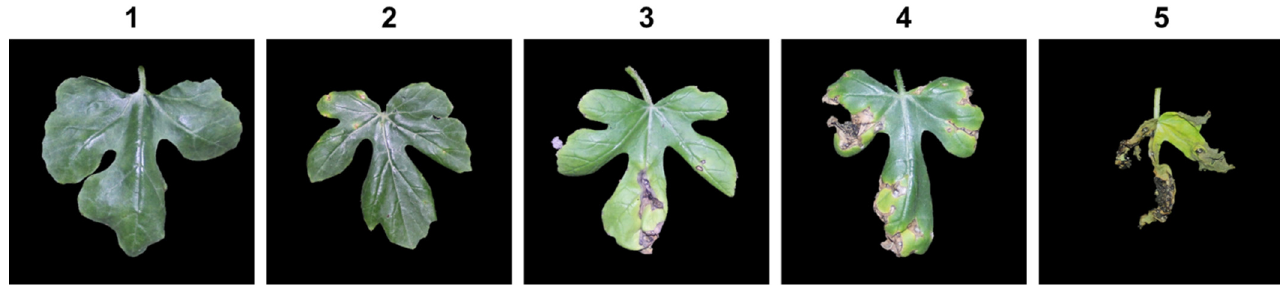
Figure 1. Scales showing the severity of disease symptoms on watermelon leaves infected with Acidovorax citrulli . Scores: 1 = <1%, 2 = 1–10%, 3 = 11–30%, 4 = 31–50%, 5 = 51–100% affected leaf area. The PDI ranges from 20 (when all leaves show scale 1) to 100 (when all leaves show scale 5 or plant is